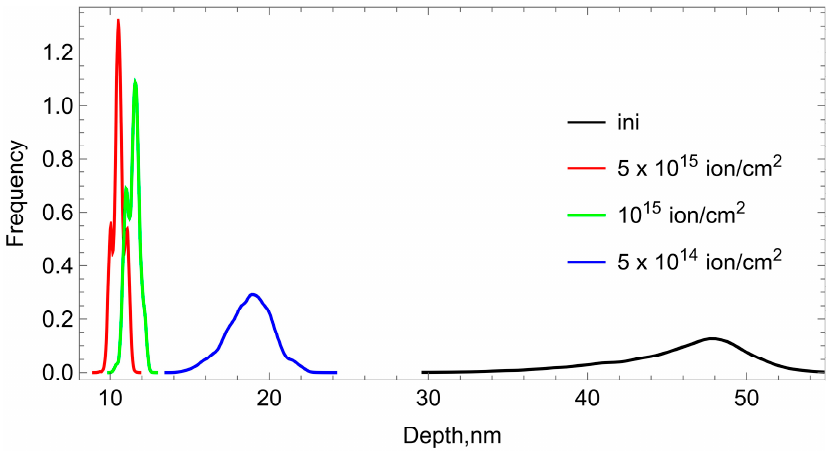
Figure 4. Distribution of maximum penetration depth at the maximum indentation force.